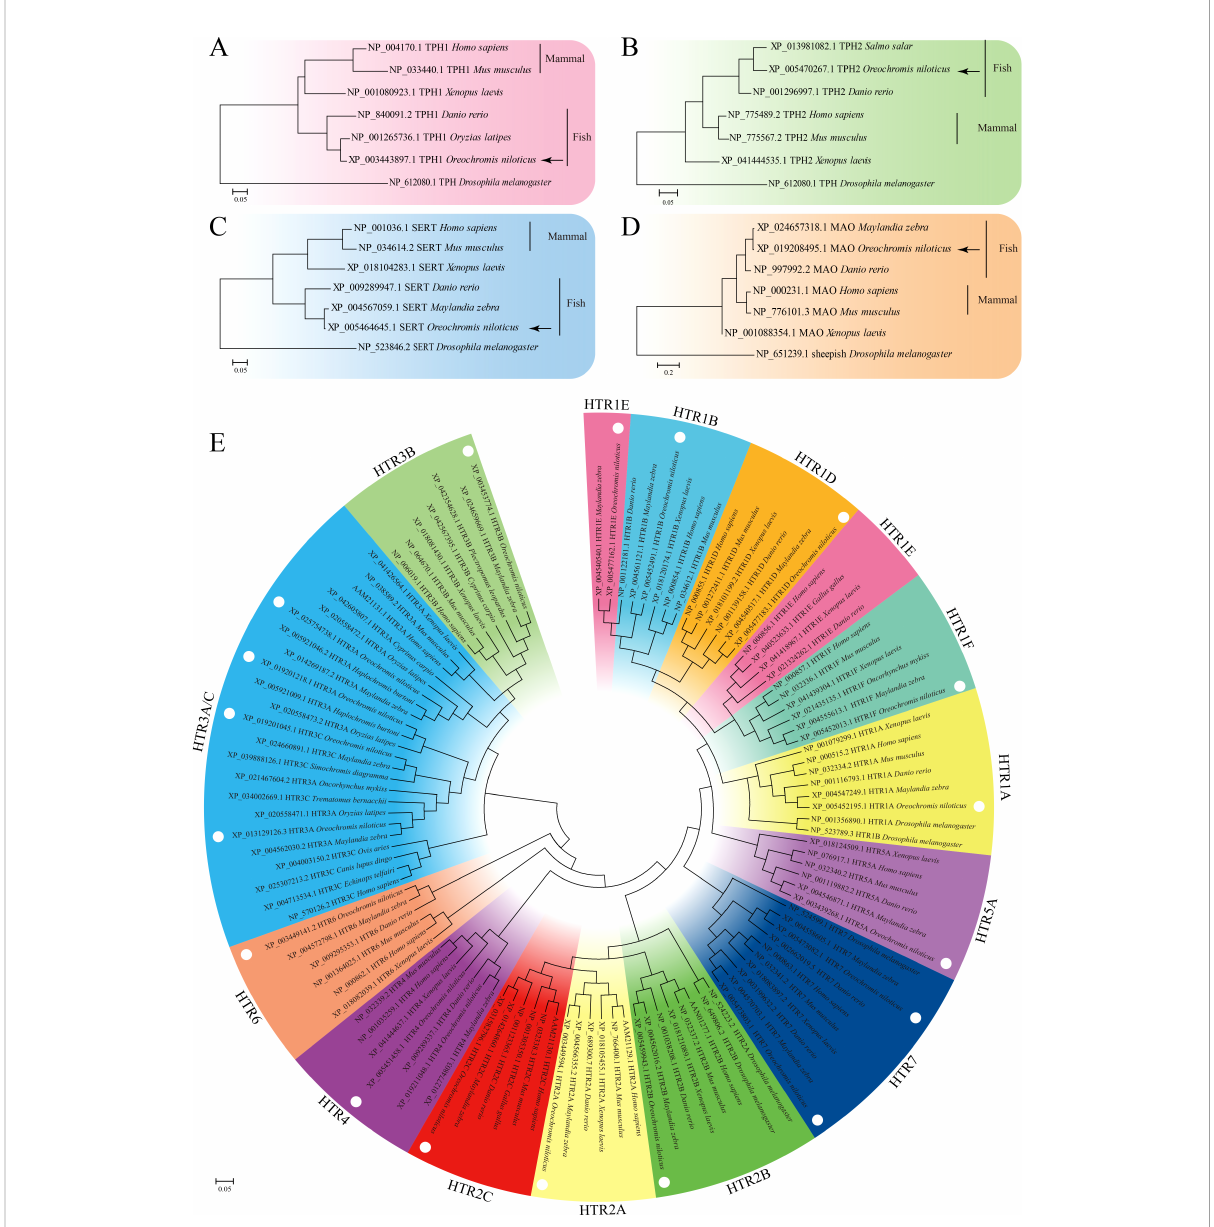
FIGURE 1 Phylogenetic tree of TPH1 (A) , TPH2 (B) , SERT (C) , MAO (D) , and HTRs (E) among distinct species constructed using the maximum likelihood (ML) method. The model animal Drosophila melanogaster was set as out